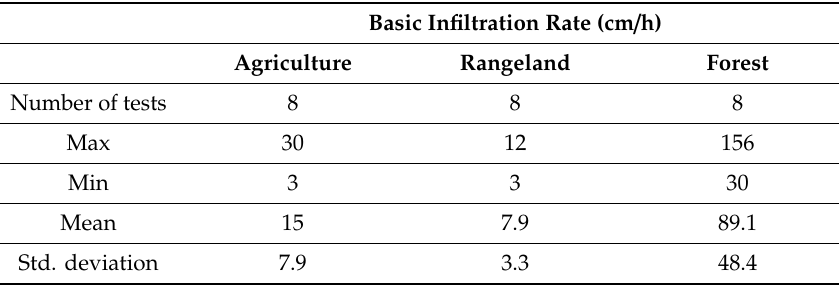
Table 8. Characteristics of hydraulic conductivity and bulk density of Kakia and Esamburmbur sub- catchments.